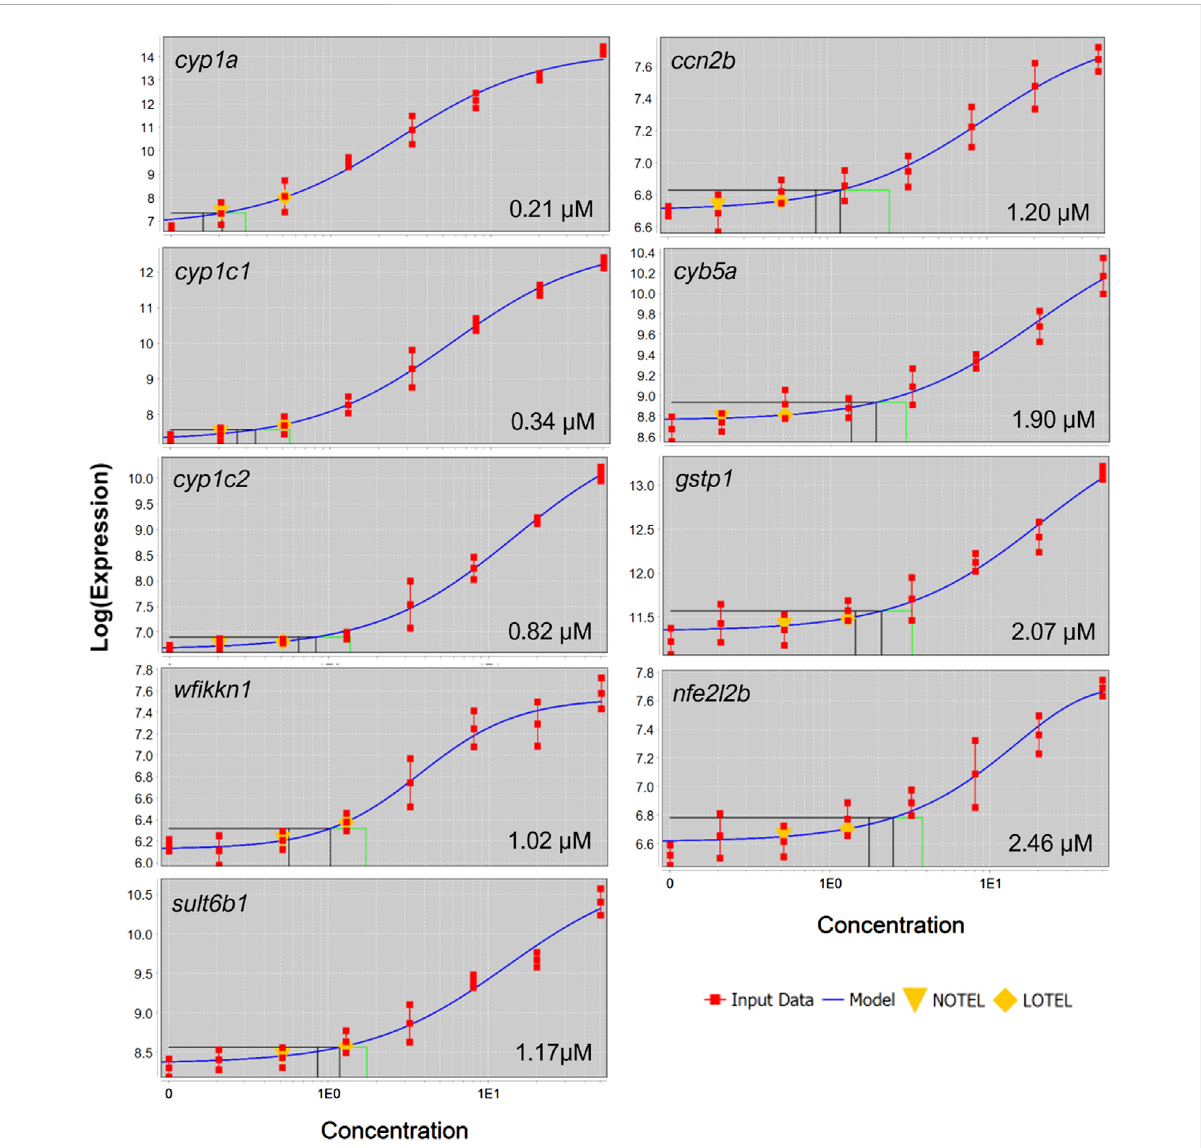
FIGURE 6 Concentration-response curves for black and green cluster genes which were differentially expressed in at four concentrations. Gene symbol and BMC are displayed in each panel.